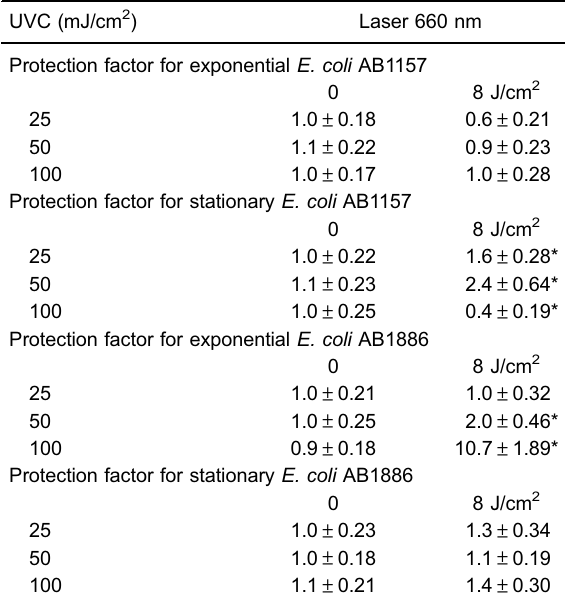
Table 2. Protection factors for low-intensity red laser radiation in E. coli exposed to ultraviolet C (UVC) radiation. UVC (mJ/cm 2 )